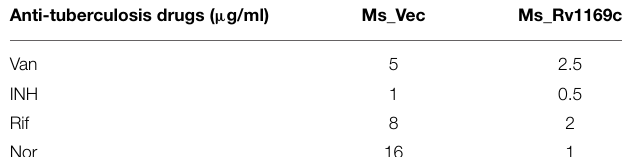
TABLE 2 | Drug sensitivity to anti-tuberculosis drugs.